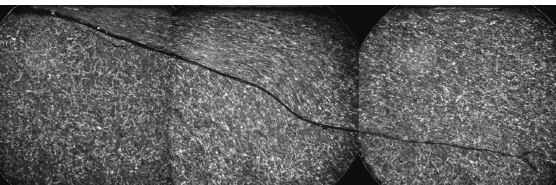
Figure 16: Composite OM image showing RCF crack in Region E3, viewed in a circumferential direction on a cross section. Running surface at top of image, field side to right. Crack length 6.2 mm, depth 2mm. Note branching at crack tip and deformed microstructure above crack. This image is from a different cross section of the same wheel shown in Figure 14, selected to show a longer crack.